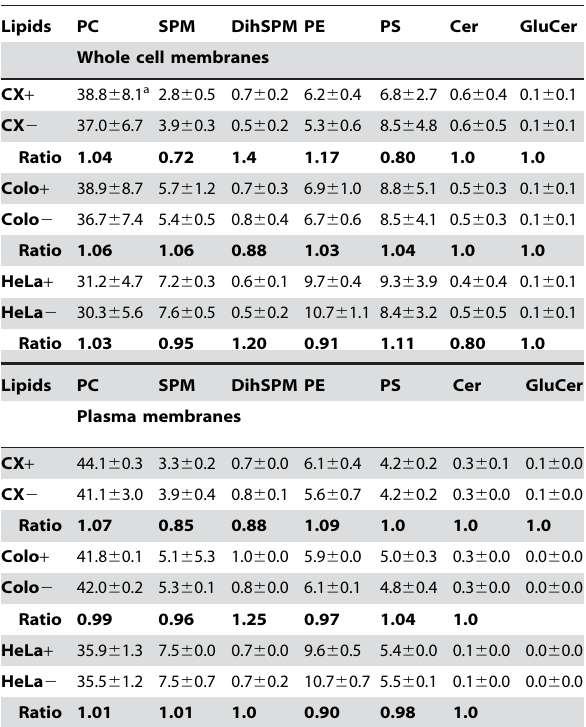
Data are displayed as the lipid content and ratio in Hsp70 membrane-positive vs membrane-negative carcinoma sublines. The calculation for total lipid content is based on the sum of all analyzed lipid classes in nM/mg protein. The lipid classes are calculated from the respective mol % value of all analyzed